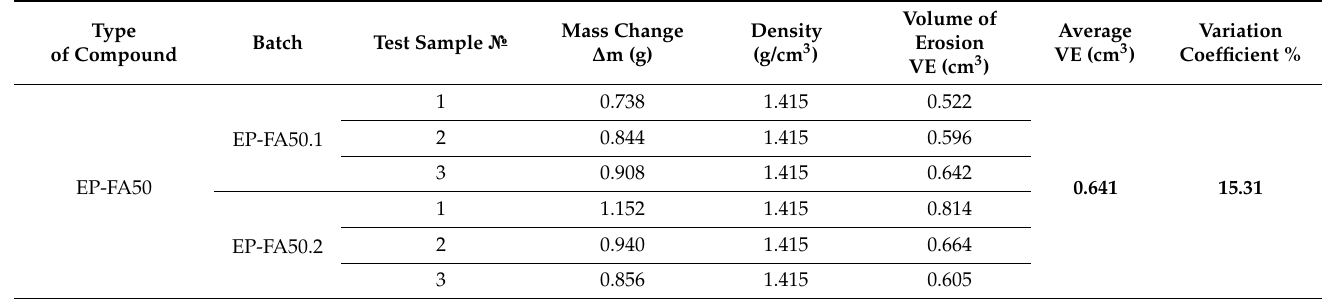
Table A13. Wear of filled epoxy binder (EP-FA50) at 23 ◦ C at an impingement angle of 90 ◦ .